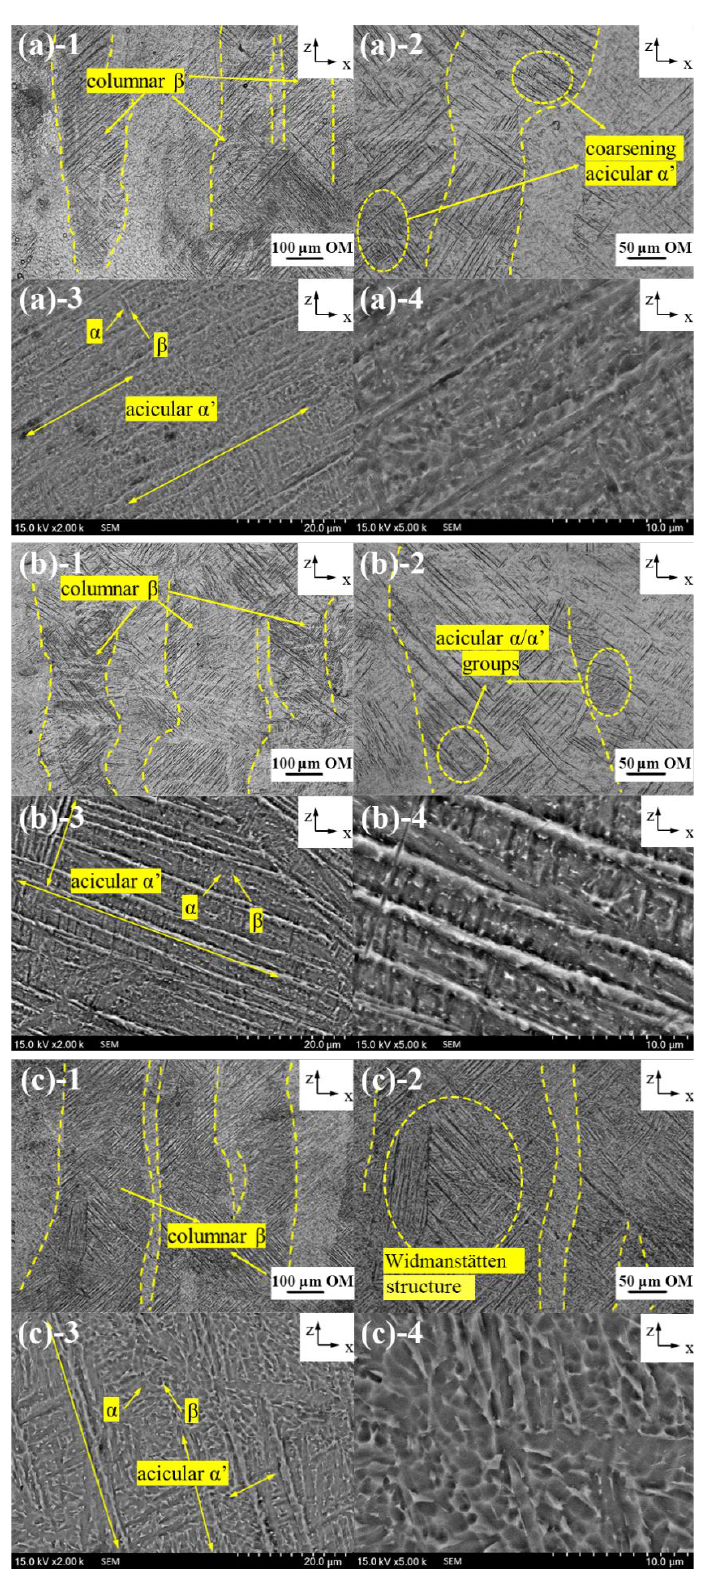
Figure 5. The microstructure of SLM TC4 under aging heat treatments ((1 – 4): OM-10×; OM-20×; SEM-2000×; SEM-5000×): ( a ) 600-2H-AC; ( b ) 600-4H-AC; ( c ) 800-2H-AC.